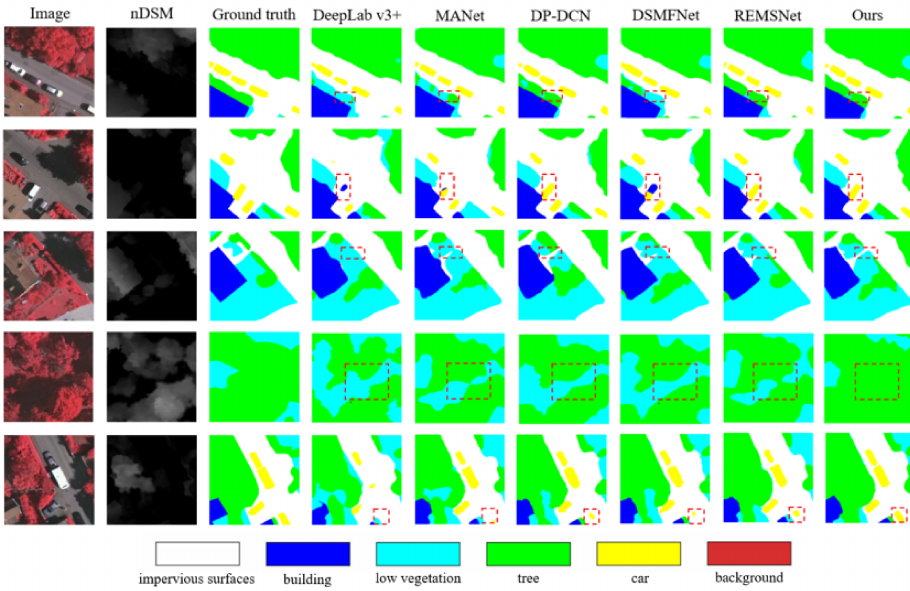
Figure 9. Experimental results of MMAFNet and other comparative methods for five images in the Vaihingen